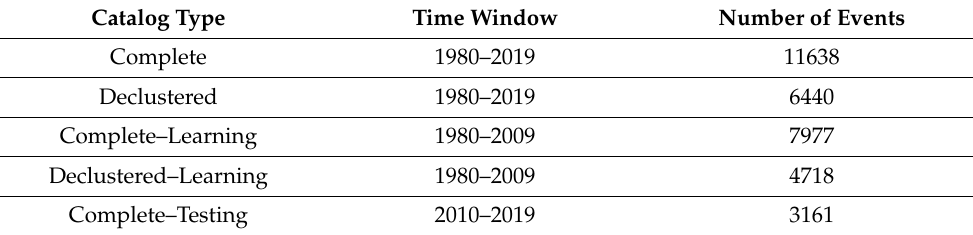
Figure 1. Location of earthquakes in the global centroid moment tensor (CMT) catalog with a depth ≤ 50 km recorded over the past almost 40 years between 1980 and 2019 [13,14]; blue letters indicate the zones of the zoom-in Figure 2. Table 1. Number of events and time windows in the different catalogs from M w ≥ 5.5.